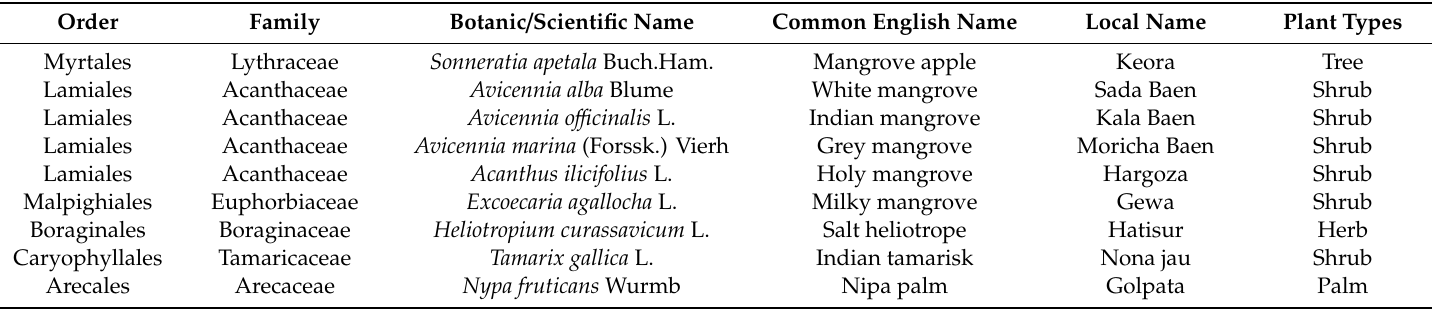
1 Global IUCN status of the species and global population trends represented here are according to the IUCN Red List of Threatened Species (IUCN 2019). Categories of IUCN status: Data Deficient (DD), Least Concern (LC), Near Threatened (NT), Vulnerable (VU), Endangered EN), Critically Endangered (CR), and Not Evaluated (NE): Taxon that has not yet been evaluated for the IUCN Red List. Table A3. Planted mangrove plant species found on the south-eastern coast of Bangladesh (Source: Modified after Arefin et al., 2017).